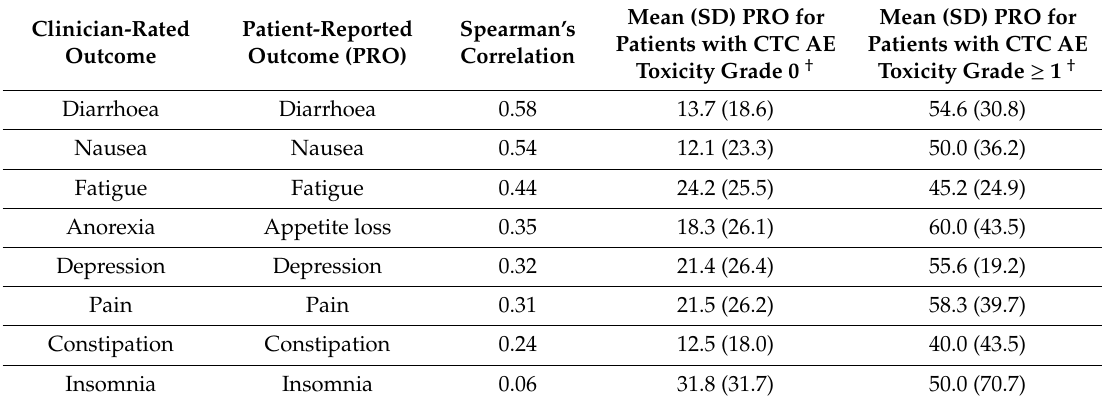
Table 3. Association between patient-reported outcomes and corresponding clinician-reported adverse events as graded by Common Toxicity Criteria (CTC-AE) at week three of chemoradiation.